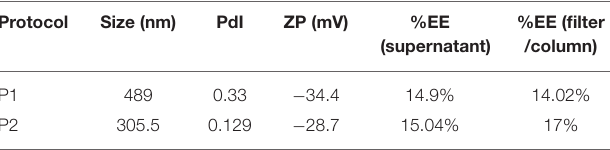
TABLE 1 | Particle size (Size), polydispersion index (PdI), zeta potential (ZP) and encapsulation efficiency (%EE) by supernatant of filter/column methods of NPs produced by P1 or P2 double emulsion